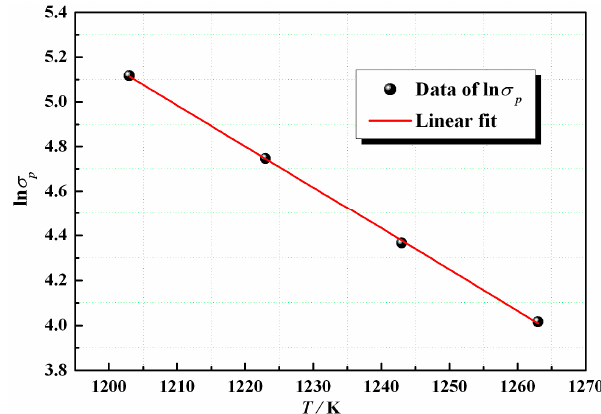
. σ ε = 1.0 × 10 − 3 s − 1 and T = 930~990 ◦ vs T at 3 1 =1.0 10 s ε p